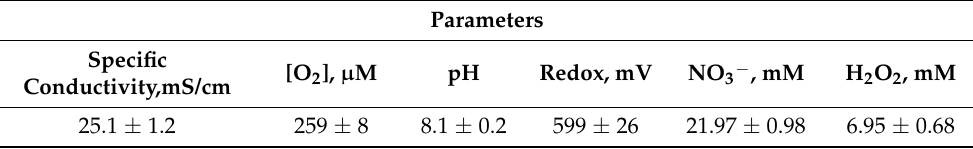
Figure 2. Photograph ( a ) and diagram of the structure of the PTS generator ( b ): 1—tank with activated solution; 2—neutral electrode (NE) brush; 3—rotor axis; 4—replaceable parts of the neutral electrode; 5—reactor lid; 6—dielectric loading; 7—replaceable active electrodes; 8—active electrode (AE) brush; 9—kinematic axis; 10—electric motor; 11—controlled power source; 12—platform; 13—aqueous solution; a—neutral output of the HF generator; b—active output of the HF generator. Table 1. Physical and chemical characteristics of the plasma-treated solution (PTS) after processing within 40